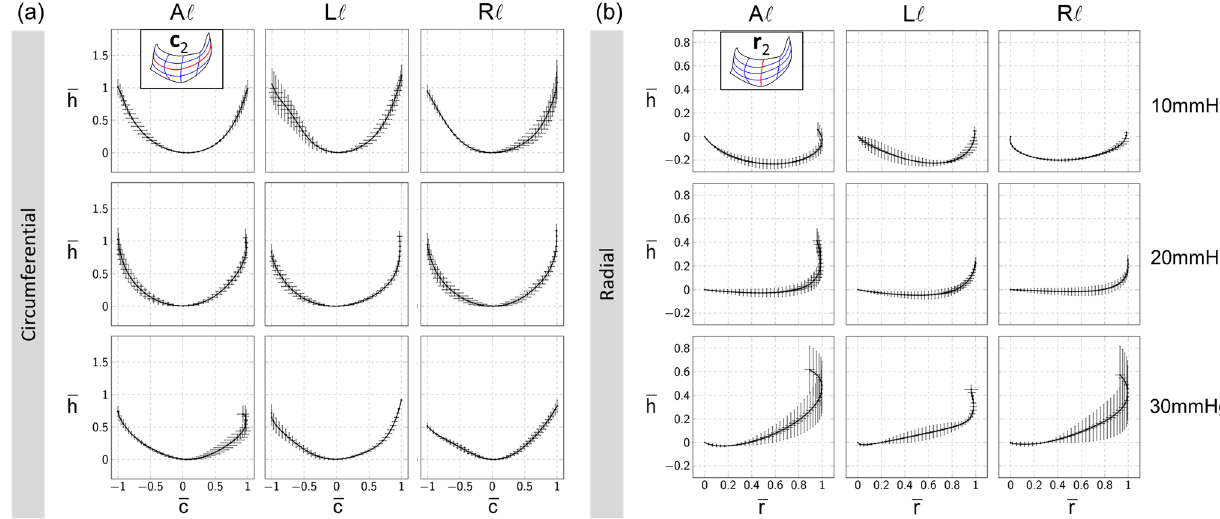
Figure 6. Representative normalized cross sections in the ( a ) circumferential and ( b ) radial directions, respectively. Rows/columns indicate different TVP and leaflets, respectively. Error bars were generated using the standard deviation from the cross sections of different samples at the same TVP. Each circumferential cross section is normalized such that the span in the normalized circumferential direction c ̅ is from − 1 to 1, while each radial cross section is normalized to span from 0 to 1 in the normalized radial direction r ̅ . In (b), h ̅ = 0 indicates the ANL plane, and r ̅ = 0 represents the end of the radial cross section on the basal attachment. Note the consistency of the cross-sectional profiles for almost all the